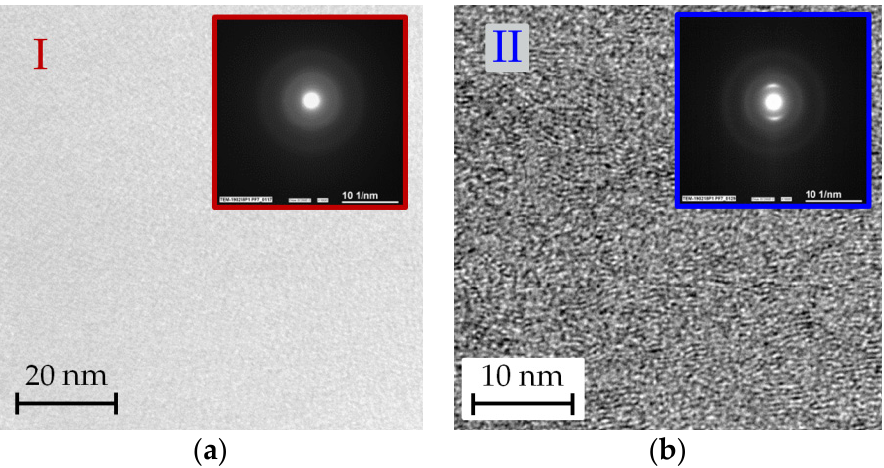
Figure 9. TEM cross-section images of coating D in high resolution and embedded SAD images. The assignment of zones I ( a ) and II ( b ) is shown in the image to the right in Figure 8.